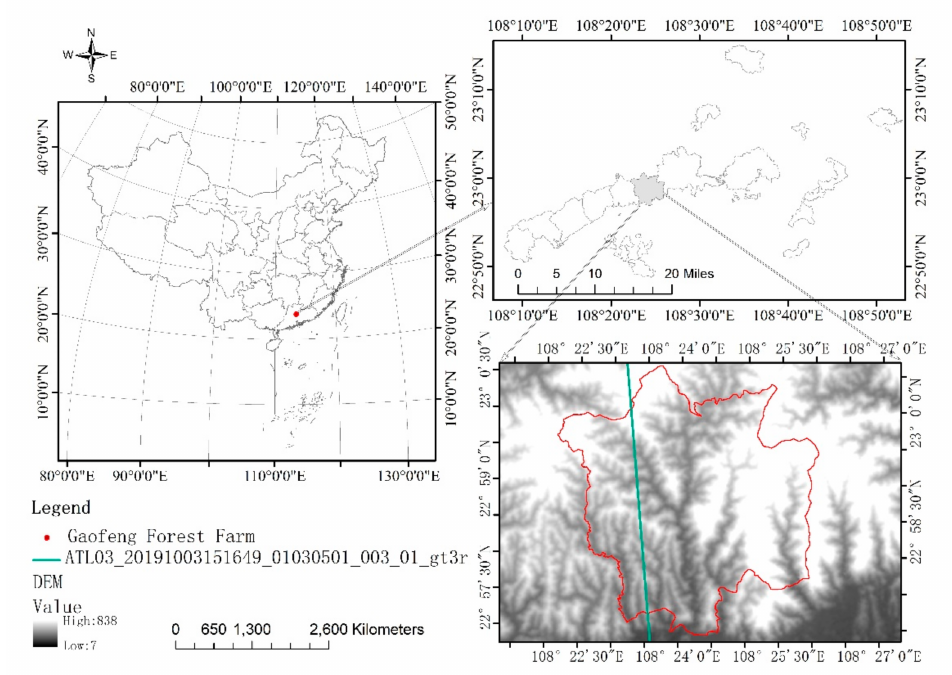
Figure 1. Location of the study